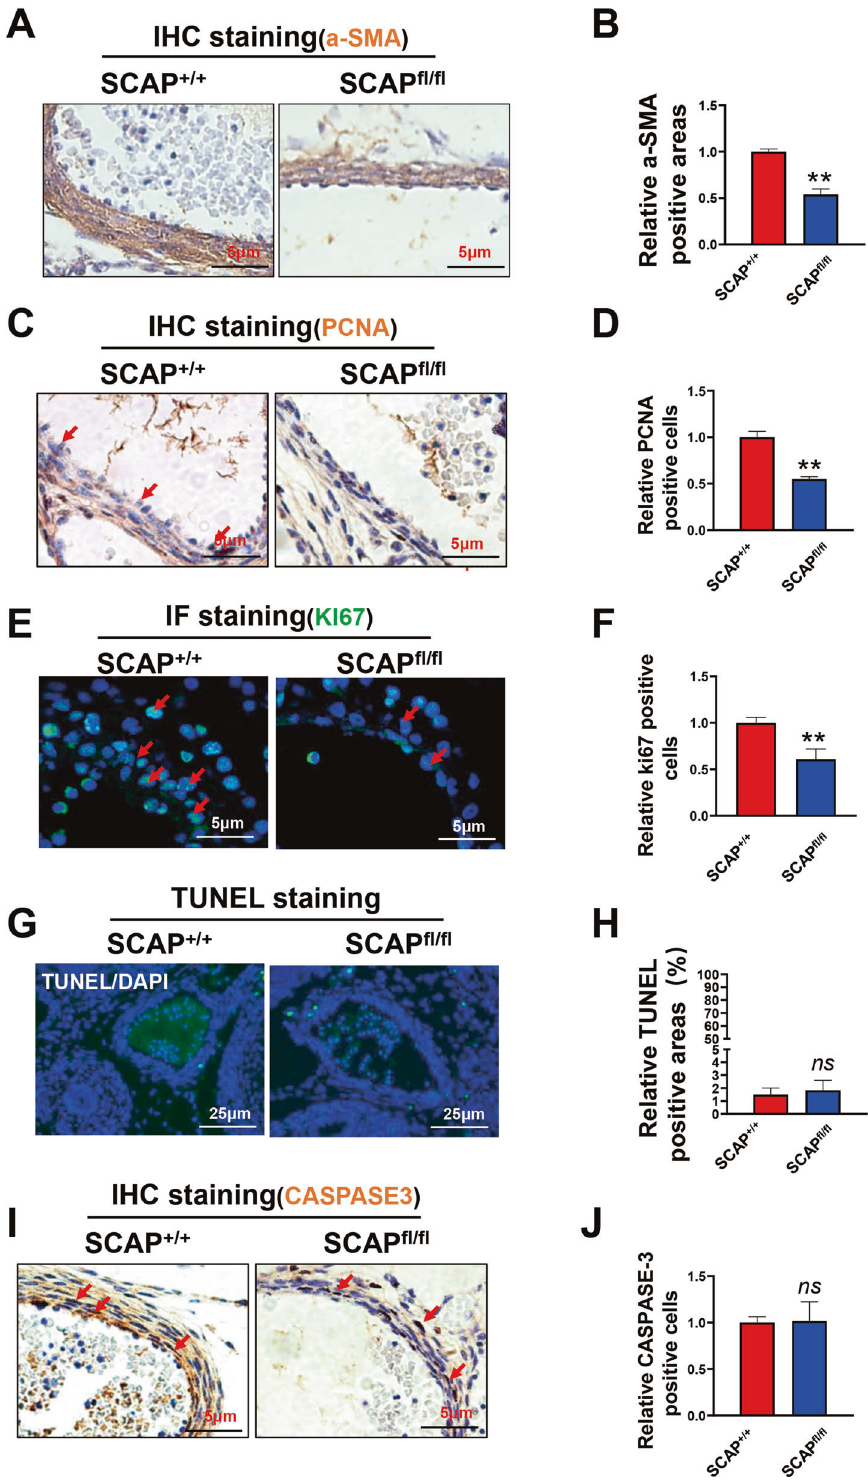
Fig. 2 Ablation of SCAP in VSMCs impairs VSMC proliferation in mouse embryos. A Immunohistochemistry analysis of α -SMA in the embryonic aorta at E14.5 ( n = 6). Scale bar = 5 μ m. B Statistical analysis of relative α -SMA-positive areas ( n = 6). C Immunohistochemistry analysis of PCNA in embryonic aortas at E14.5 ( n = 6). Scale bar = 5 μ m. D Statistical analysis of relative PCNA-positive cells ( n = 6). E Immuno fl uorescence staining of Ki67 in the embryonic aorta at E14.5 ( n = 6). Scale bar = 5 μ m. F Statistical analysis of relative Ki67-positive cells ( n = 6). G Representative images of TUNEL staining of embryonic aortas at E14.5 in each group ( n = 6). Scale bar = 25 μ m. H Quanti fi cation of relative TUNEL-positive areas in each group ( n = 6). I Immuno fl uorescence staining of CASPASE-3 in the embryonic aorta at E14.5 ( n = 6). Scale bar = 5 μ m. J Statistical analysis of the relative number of CASPASE-3 positive cells ( n = 6). Data are presented as the mean ± SD. * P < 0.05, ** P < 0.01, *** P < 0.001. P values were calculated by Student ’ s t test.